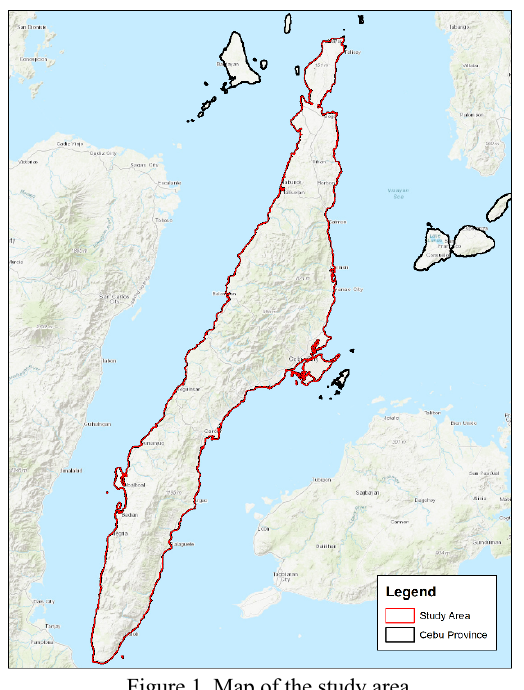
Figure 1. Map of the study